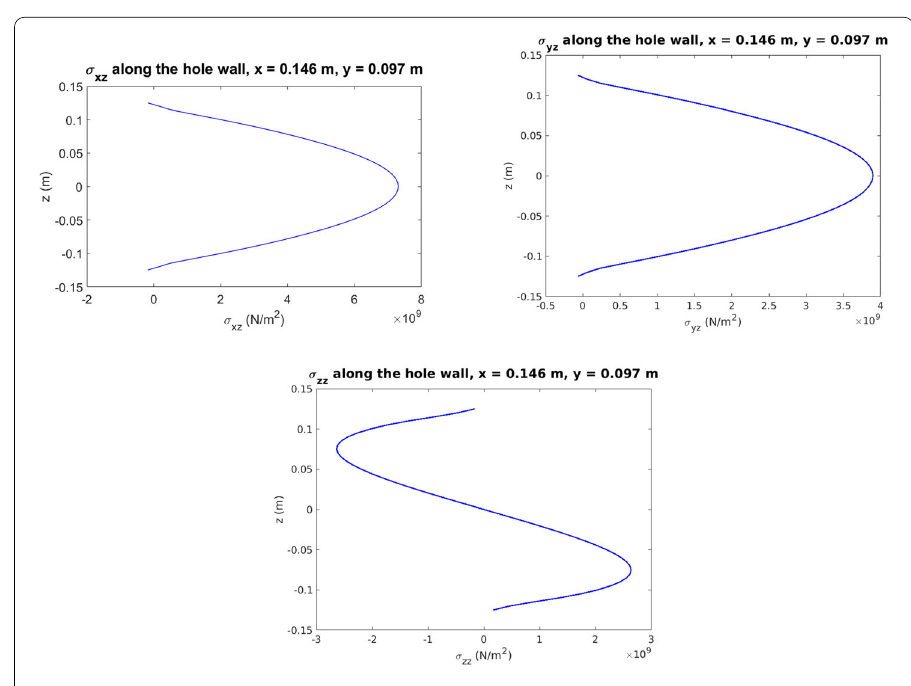
Fig. 7 Out-of-plane stress tensor components around the hole for x = 146 mm and y = 97 mm using the minimally-intrusive fully 3D separated plate formulation